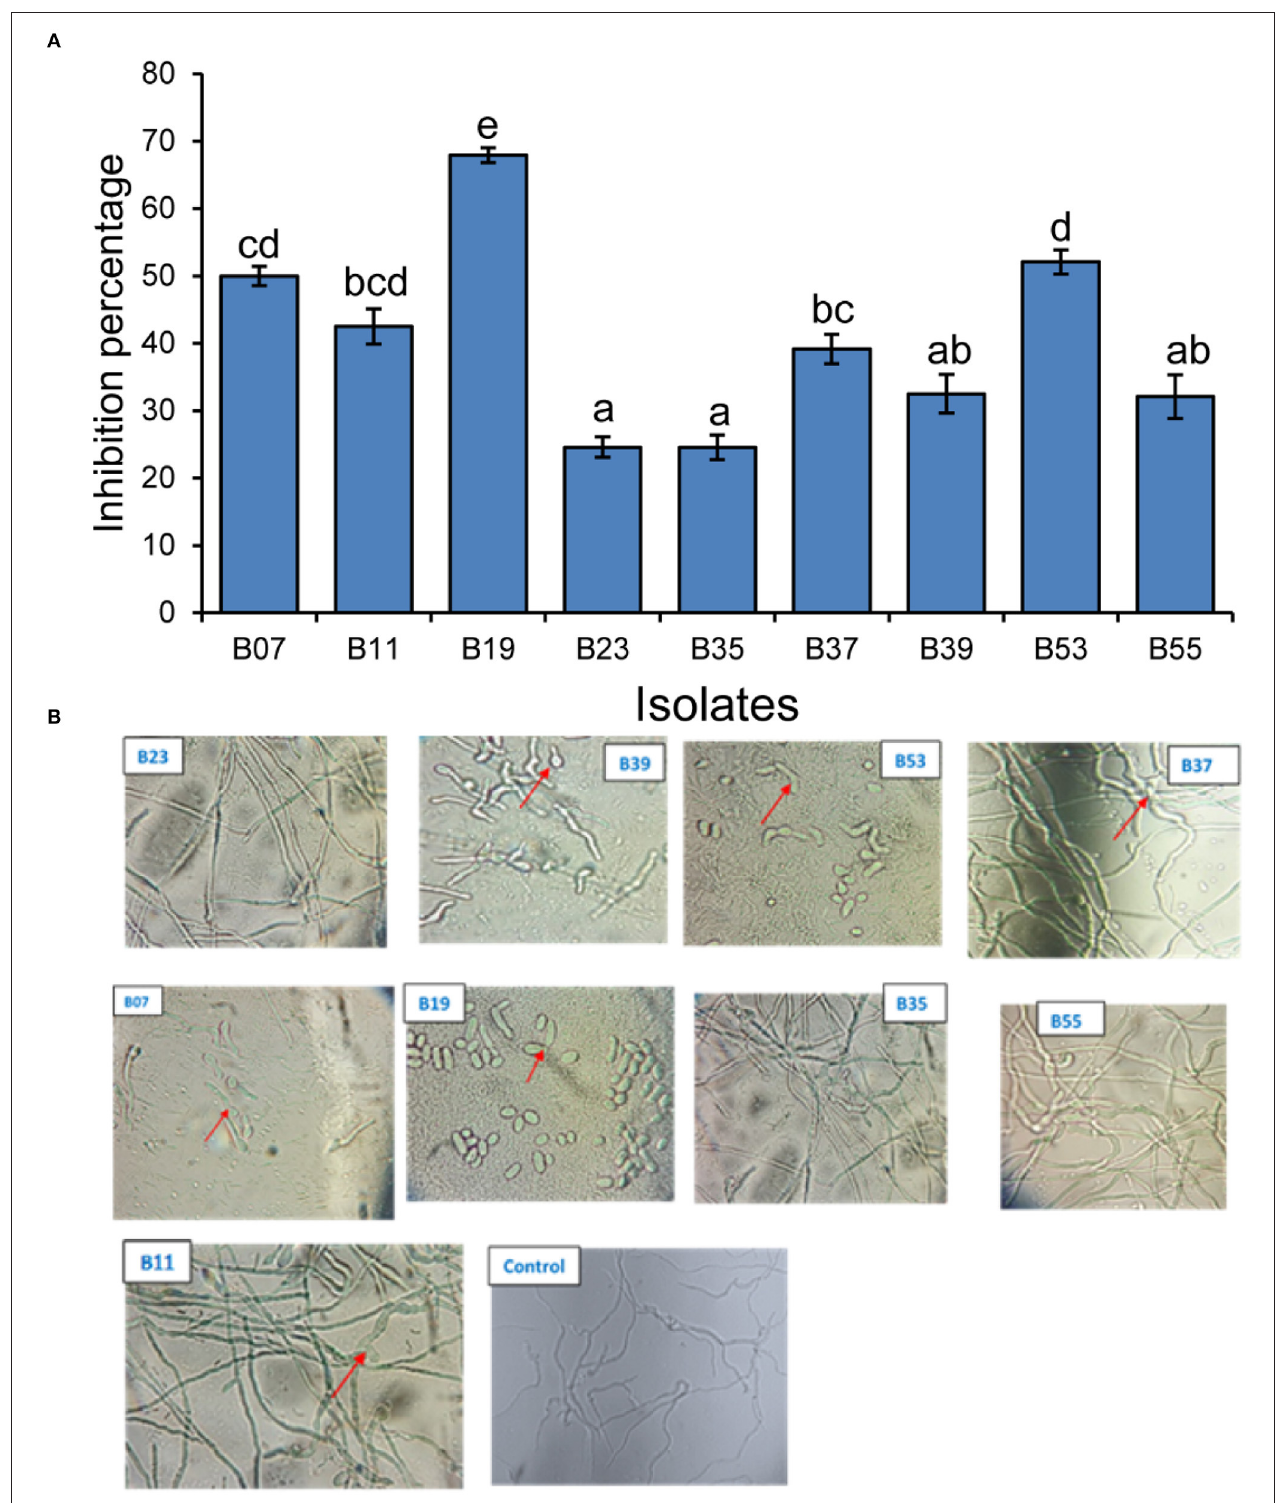
FIGURE 3 | Inhibitory effect of bacterial endophytes on Fusarium solani mycelial and spores. (A) Bar plot shows the mean inhibition percentage of each isolate. Error bars represent SEM. Bars with different letters are significantly different from each other (GLM with binomial distribution followed by the analysis of deviance test, n = 3). (B) Pictures showing the effect of the interaction of Fusarium solani spores with bacterial endophyte cells after incubation in mixed culture plates for 24h. Arrows in B39 and B07 indicate delayed emergence of germ tubes from spores; B53 and B19 indicate non-germinated and morphological changes in spores; B11 and B37 indicate morphological changes in the growing mycelium. Control plate contained only F. solani